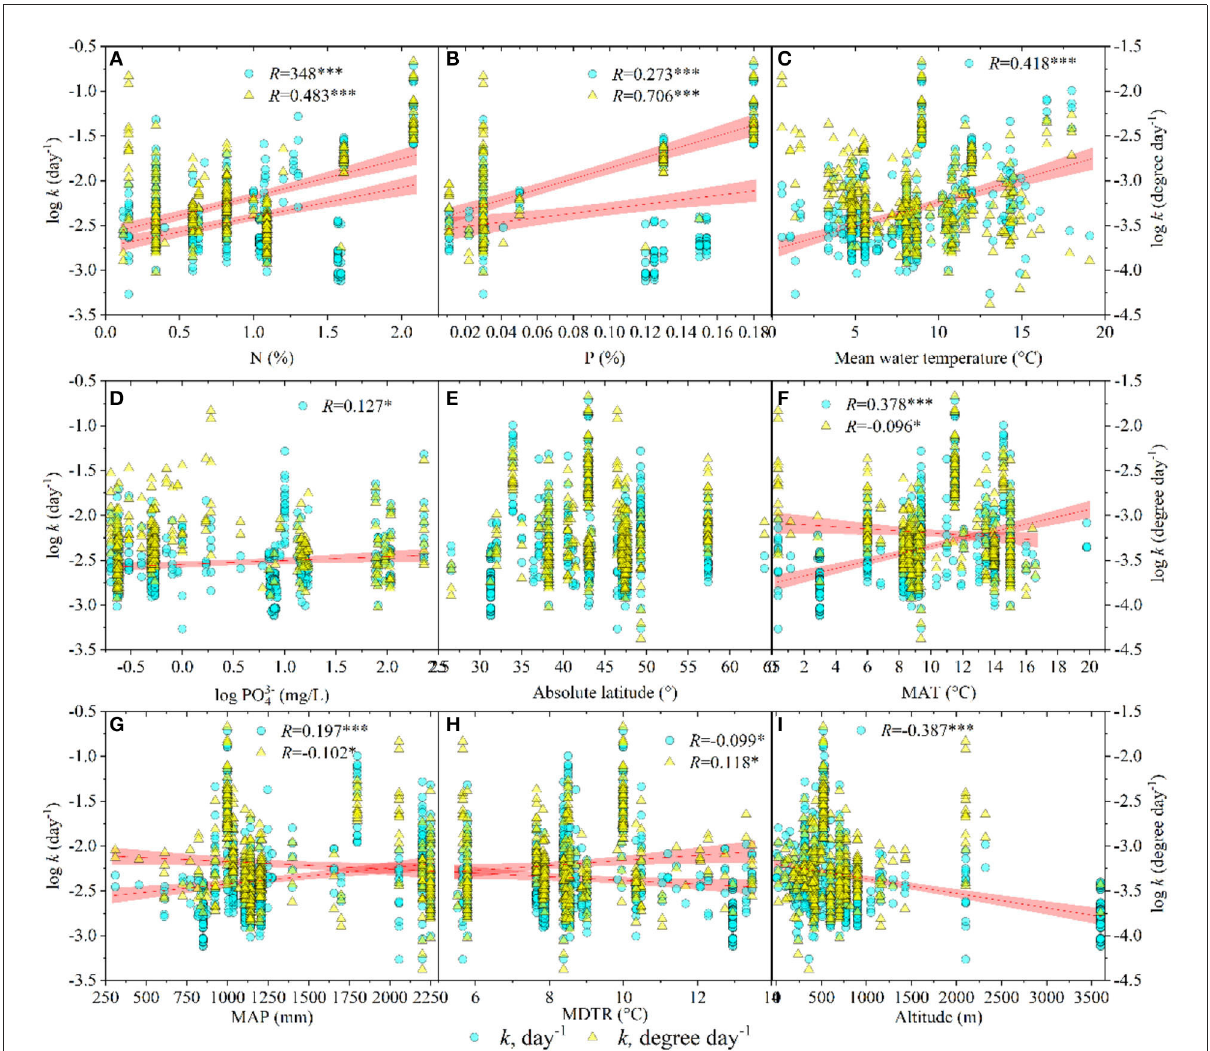
FIGURE4 (A–I) Relationships between coniferous leaf-litter breakdown rates (per day, circle; per degree day, triangle) and selected important leaf-litter traits (N and P), stream physicochemical characteristics (mean water temperature and PO 3- 4 ), and geographic and climatic (latitude; MAT, mean annual temperature; MAP, mean annual precipitation; MDTR, mean diurnal temperature range; and altitude) predictors. R values with significant correlations are shown in the figure. *** P < 0.001. Linear fitted lines and 95% confidence intervals are